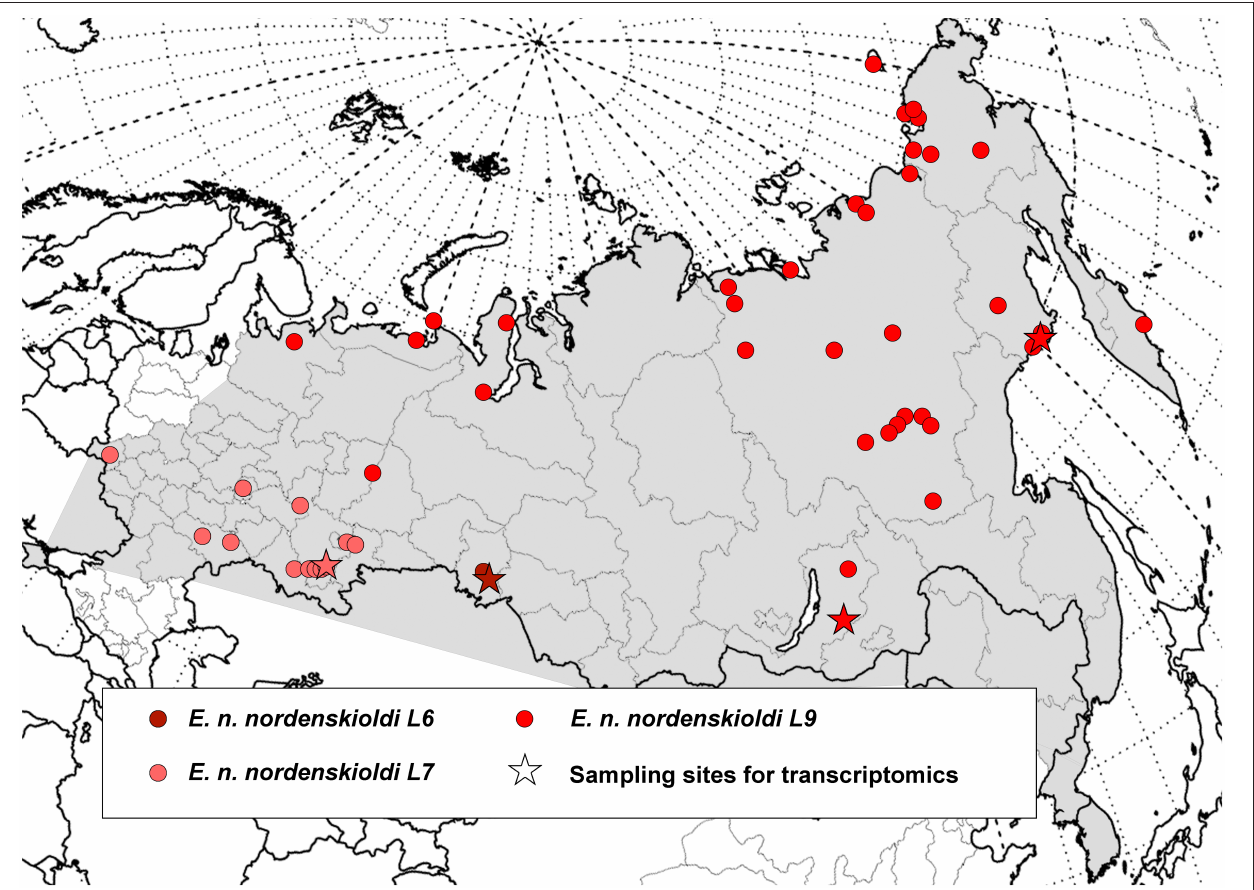
FIGURE 1 | Geographic distribution of the genetic lineages of E. nordenskioldi . Distribution of the E. nordenskioldi complex is shown in gray. Color and symbol code refers to Figures 2 – 4 .